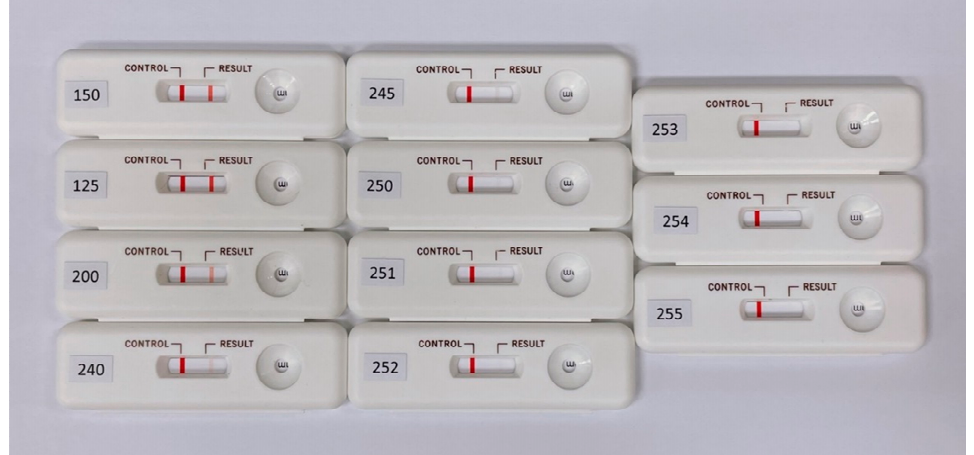
Figure 4. Designed self-made simulated rapid test strips with different grayscale values ranging from 125 to 255 for the T line.